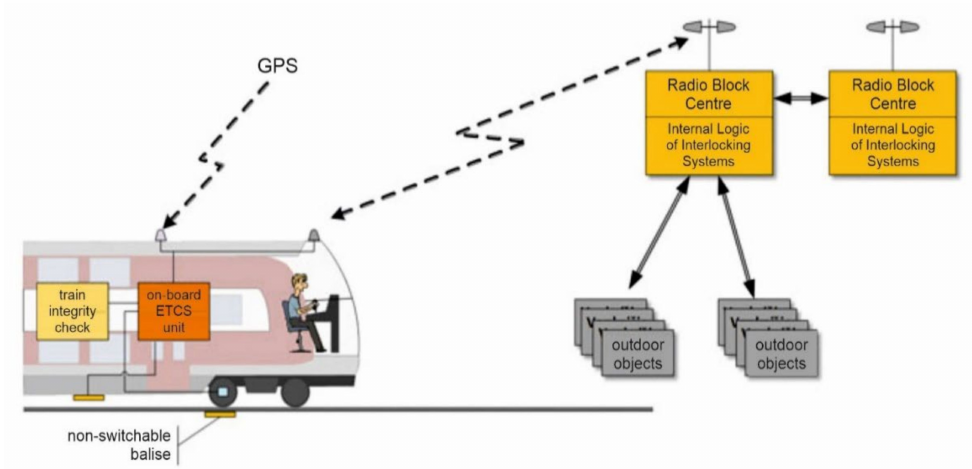
Figure 4. Visual demonstration of ETCS L3 components